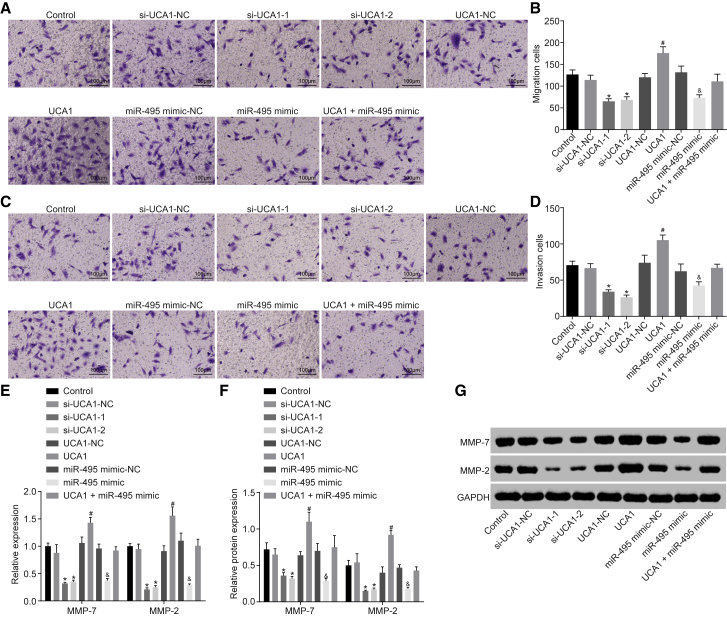
GC Cell Migration and Invasion Were Both Promoted by Upregulated UCA1 and Downregulated miR-495(A) Cell migration detected by Transwell assay. (B) The number of migrating cells in each group. (C) Cell invasion detected by Transwell assay. (D) The number of invasive cells in each group. (E) The mRNA expression of MMP-7 and MMP-2 detected by qRT-PCR. (F) The protein level of MMP-7 and MMP-2 detected by western blot analysis. (G) Band patterns of MMP-7 and MMP-2. *p < 0.05, versus the si-UCA1-NC group; #p < 0.05, versus the UCA1-NC group; &p < 0.05, versus the miR-495 mimic-NC group (measurement data were expressed as mean ± SD and analyzed by independent sample t test; each experiment was conducted three times independently).